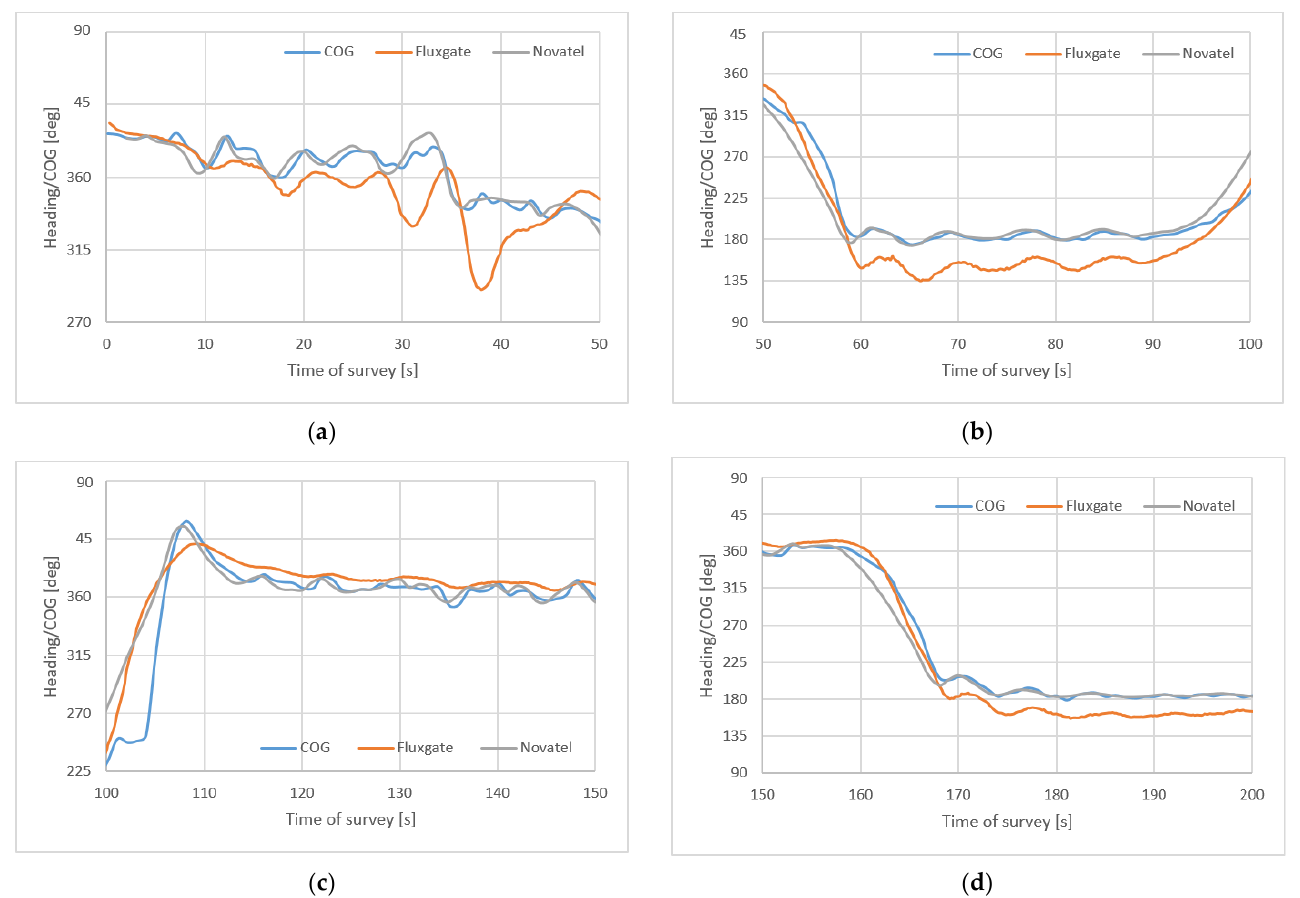
Figure 8. A part of the USV survey on the first ( a ), second ( b ), third ( c ) and fourth ( d ) profiles.